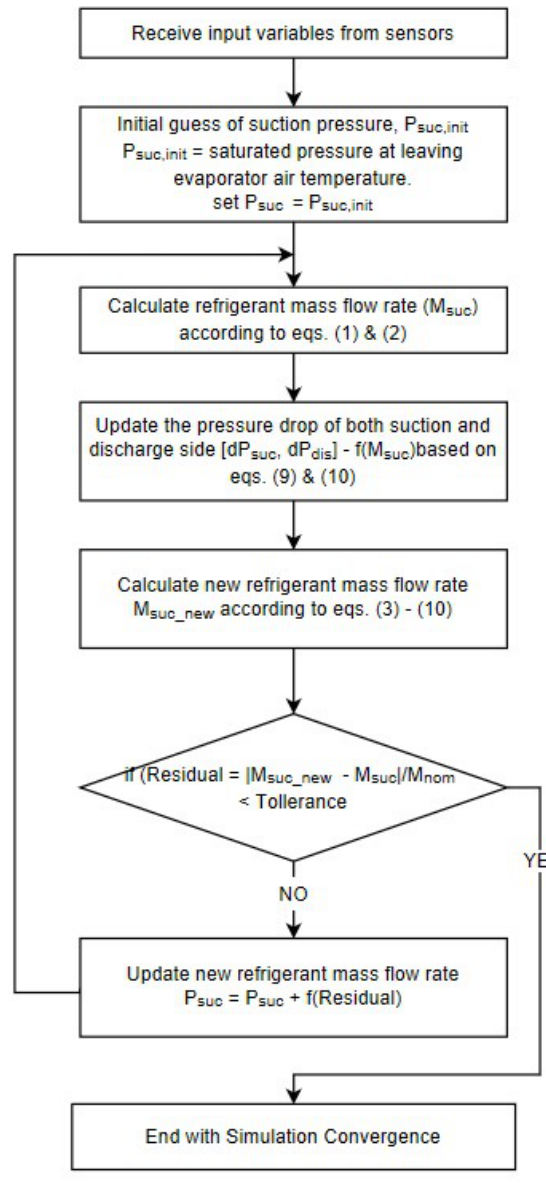
Figure 2. Pressure calculation based on compressor and EXV characteristics.